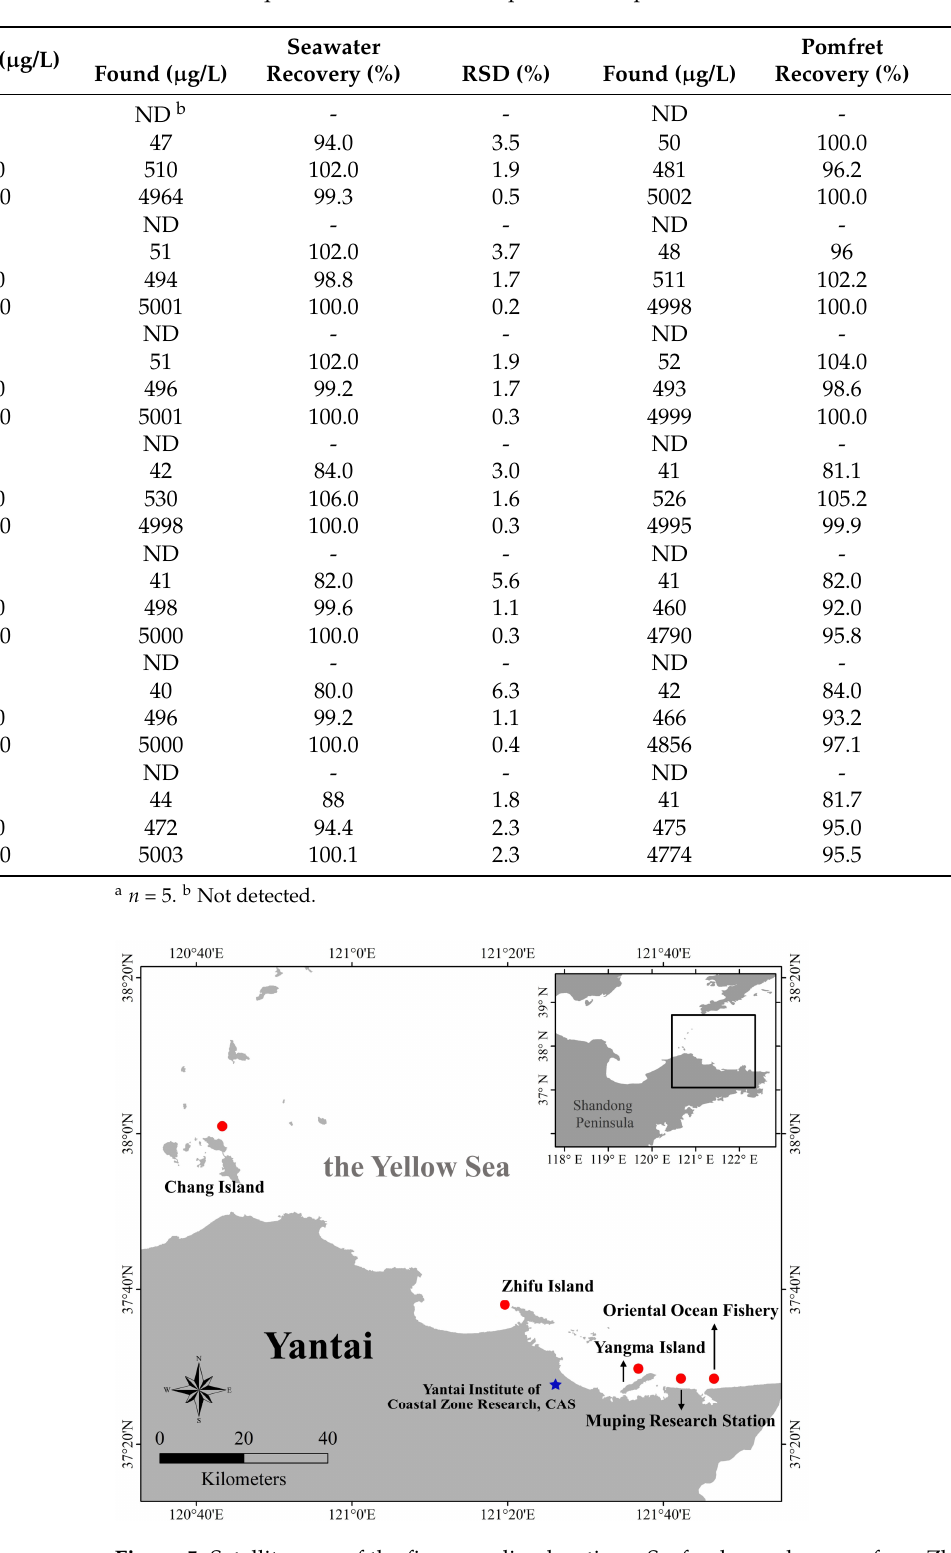
Table 2. Found values and recovery of the UA-DLLME-HPLC-DAD method for the determination of seven SAs in aquaculture seawater and pomfret samples a .